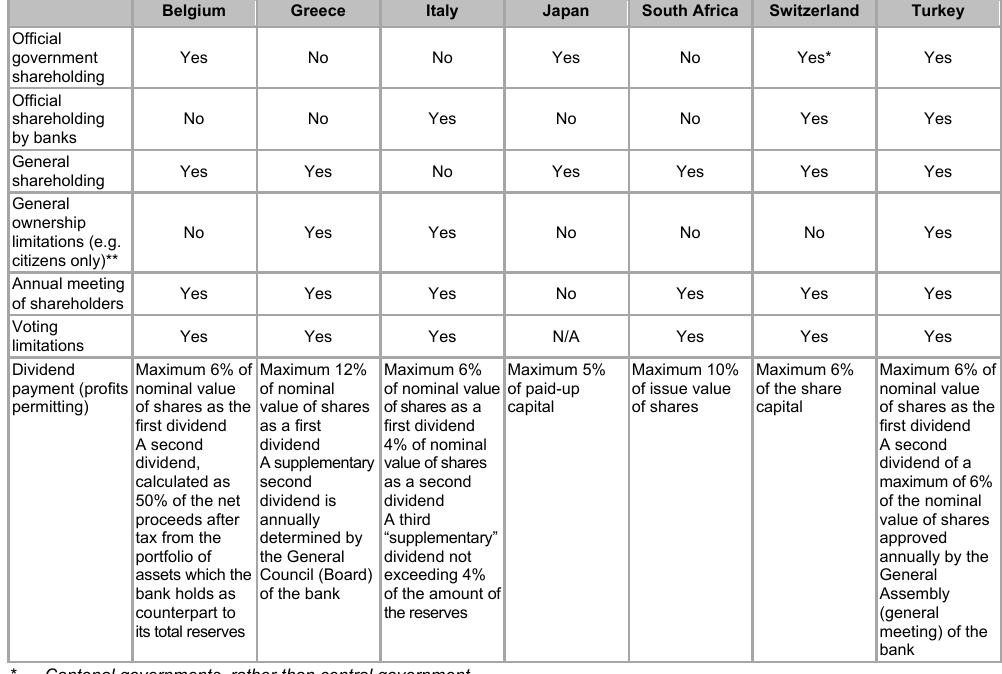
Table 1 Summary of the salient features of central banks with shareholders Belgium Greece